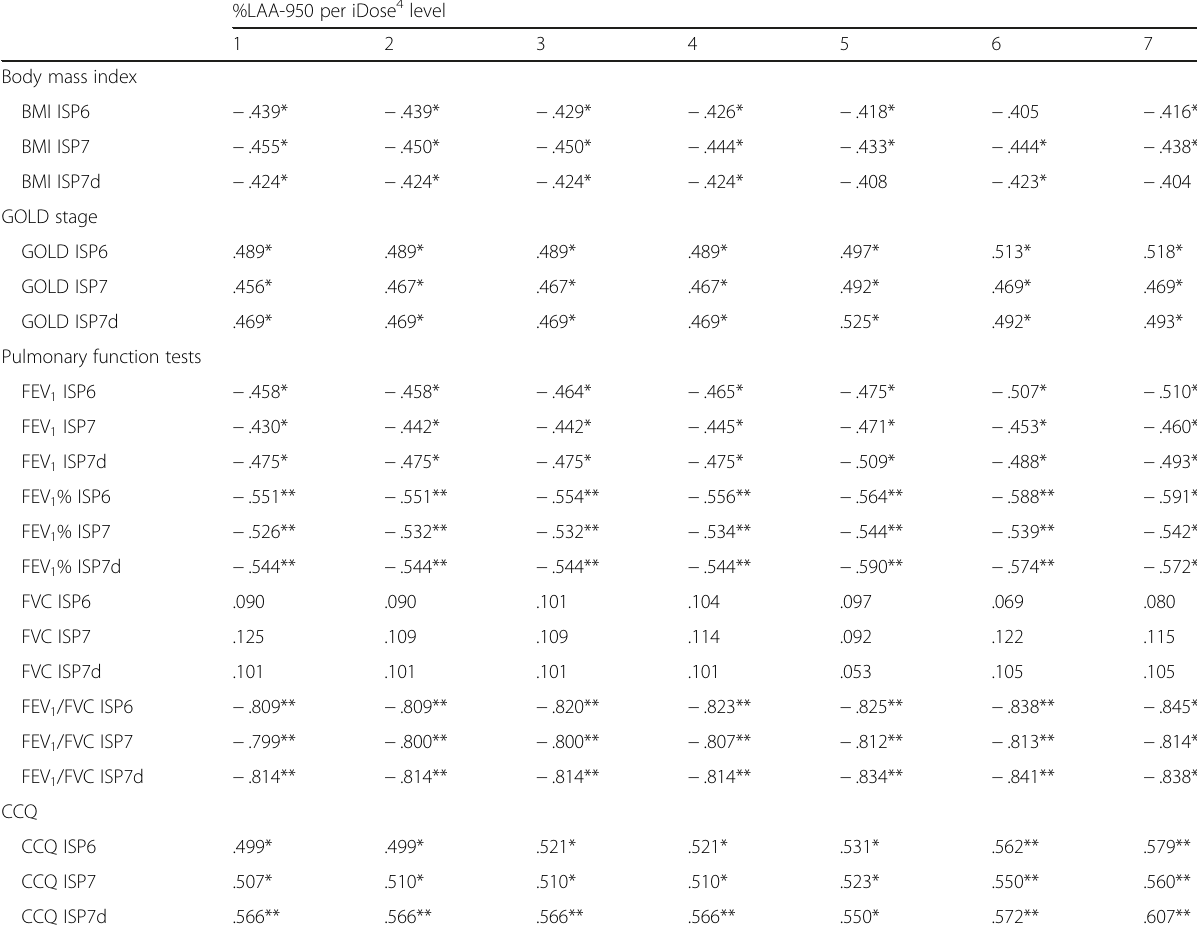
Table 2 Spearman correlation